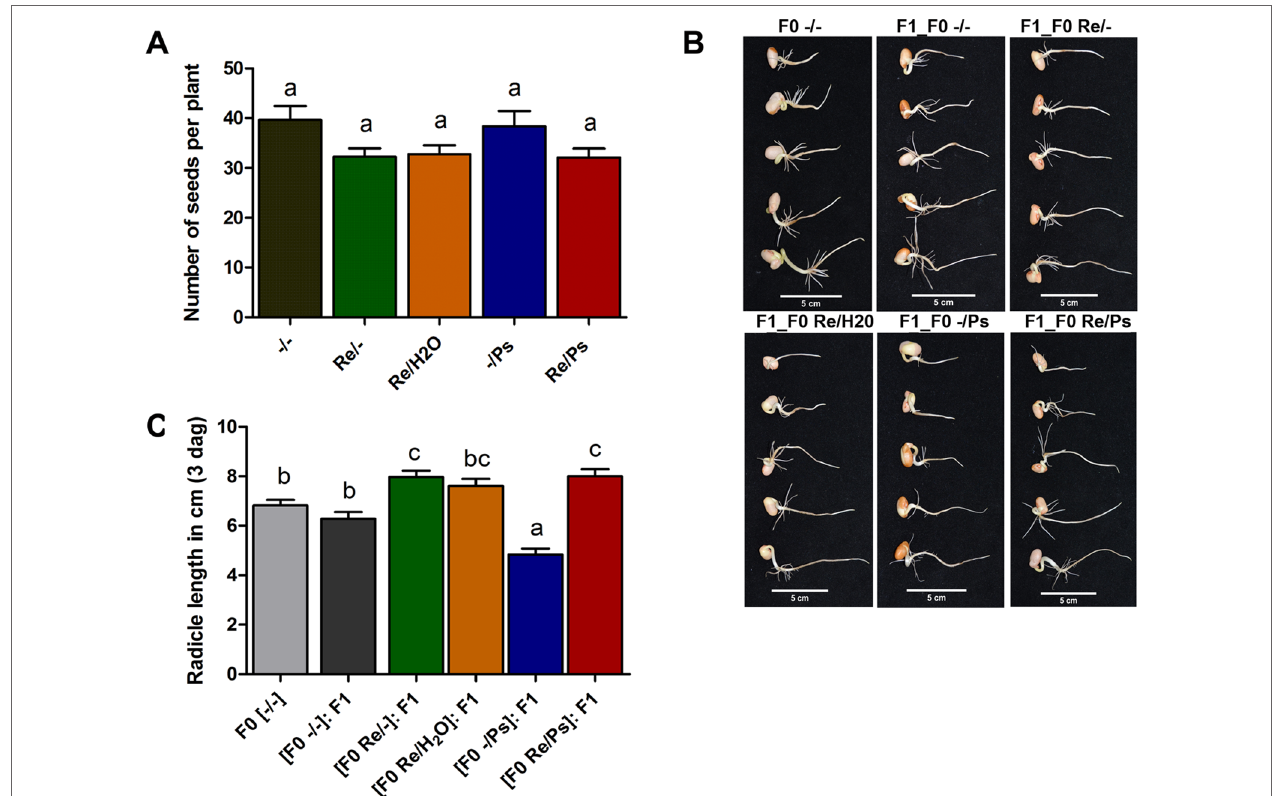
FIGURE 8 | (A) Number of seeds produced in plants from the different treatments (Re/Ps, Re/H2O, Re/-; -/Ps, and -/-). Data are mean ± SD from six independent plants (n = 6) per experiment, from three independent experiments. (B-C) Radicle length of F1 seedlings three days after germination. Scale = 5 cm. Data are mean ± SD from 75 independent seeds (n = 75), from three independent experiments. Statistical significance was determined using one-way ANOVA followed by Tukey’s multiple comparison test, p < 0.05. Means with the same letter are not significantly